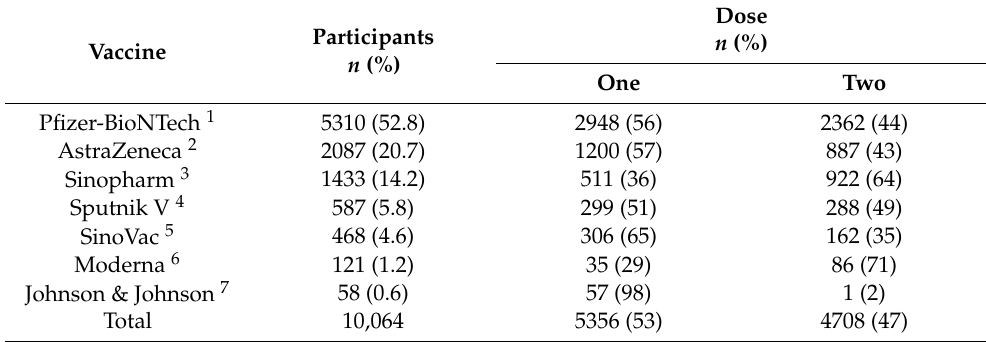
Table 3. Classification of participants based on types of COVID-19 vaccines and number of